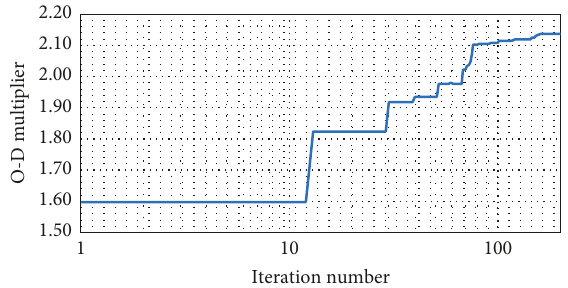
Figure 3: Convergence graph of the Algorithm 2 for Test Network-1.